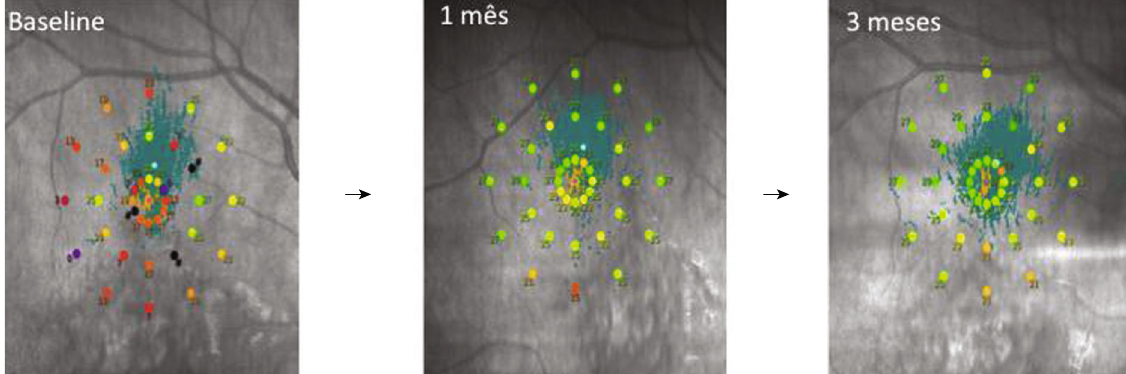
Figure 4: Microperimetry of patient #4 at baseline, 1 and 3 months after IV. Detail of the 36 points tested and their